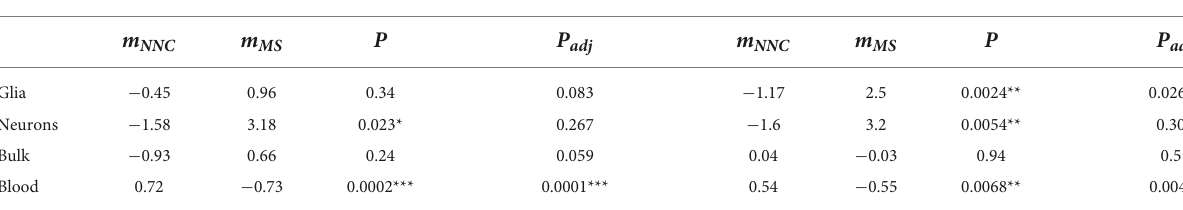
TABLE 3 Summary statistics of AAR comparisons between MS patients and controls. Horvath’s clock Cortical